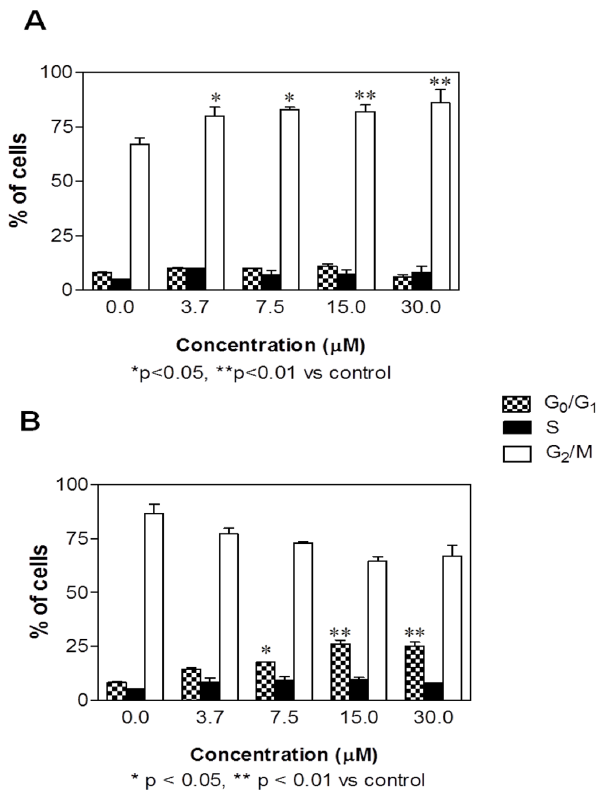
Figure 9. Cell-cycle distribution following 24 h culture in the absence or presence of SR in normoxic (A) and hypoxic (B) conditions on REH cells. Data are means 6 SEM of four independent